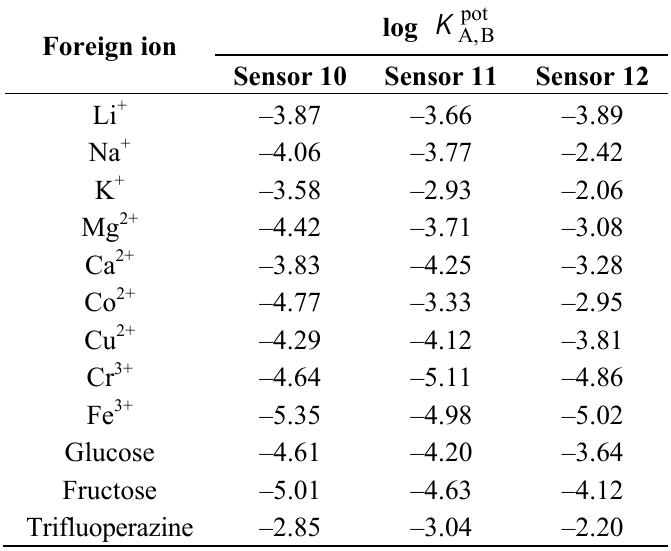
Table 2. Selectivity coefficients of promethazine sensors towards cations, trifluoperazine and